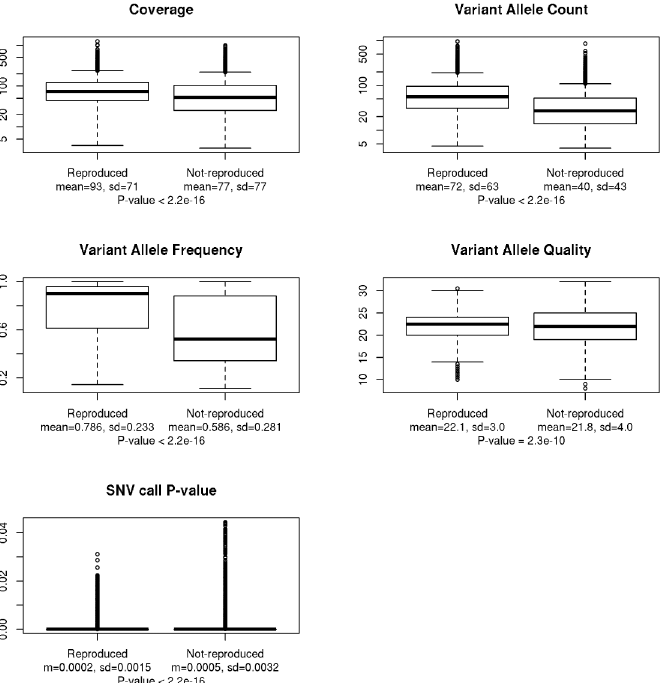
Fig 2. Boxplots comparing the values of different factors between the pooled reproduced and not- reproduced SNV calls. The factors include coverage, variant allele count, variant allele frequency, variant allele quality, and p-value of SNV calls. The numbers beside each boxplot indicate the mean ± standard deviation of the factor values in the group of SNV calls. T-test p-values are shown.